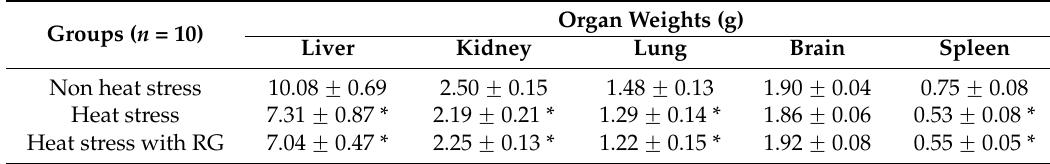
Table 2. Absolute organ weights of SD rats.